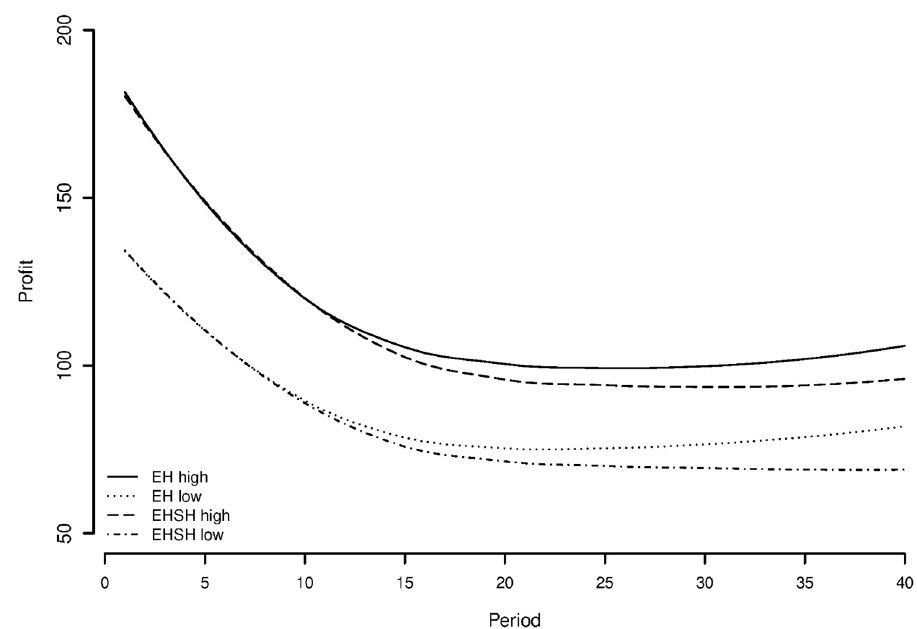
Fig 13. Profit of higher ( E = 60) and lower ( E = 40) endowed players in economic heterogeneity [EH] and economic and sociocultural heterogeneity [EHSH] treatment (smoothed